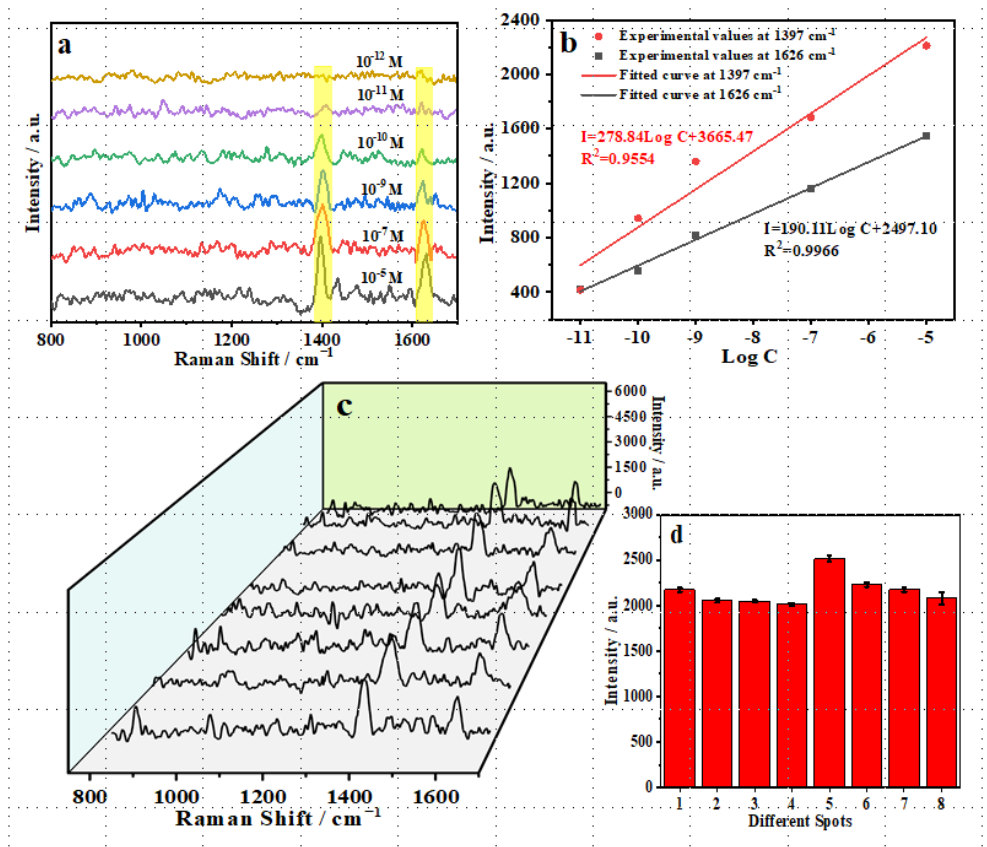
Figure 7. SERS spectra of different concentrations of OFL obtained from TM@TiO 2 @Ag ( a ); linear relationship between Raman intensity of OFL at the peak of 1397 and 1626 cm − 1 and the concentra- tions range of 10 − 5 ~10 − 11 M ( b ); a series of SERS spectra of OFL at 10 − 5 M from 8 different random spots ( c ); the intensity of OFL at 10 − 5 M at 1397 cm − 1 in the SERS spectra ( d ).